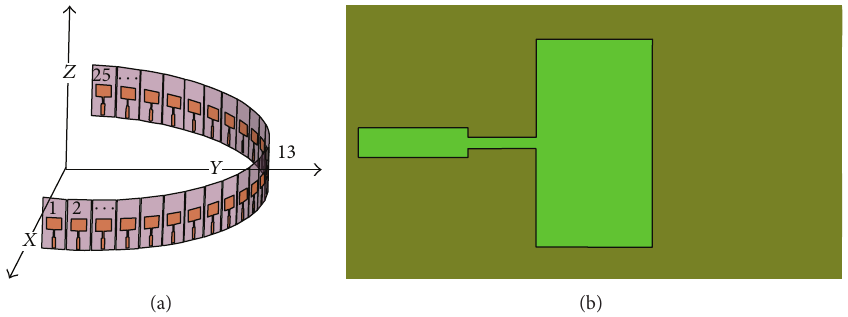
Figure 4: (a) Half-circular array antenna. (b) Microstrip patch